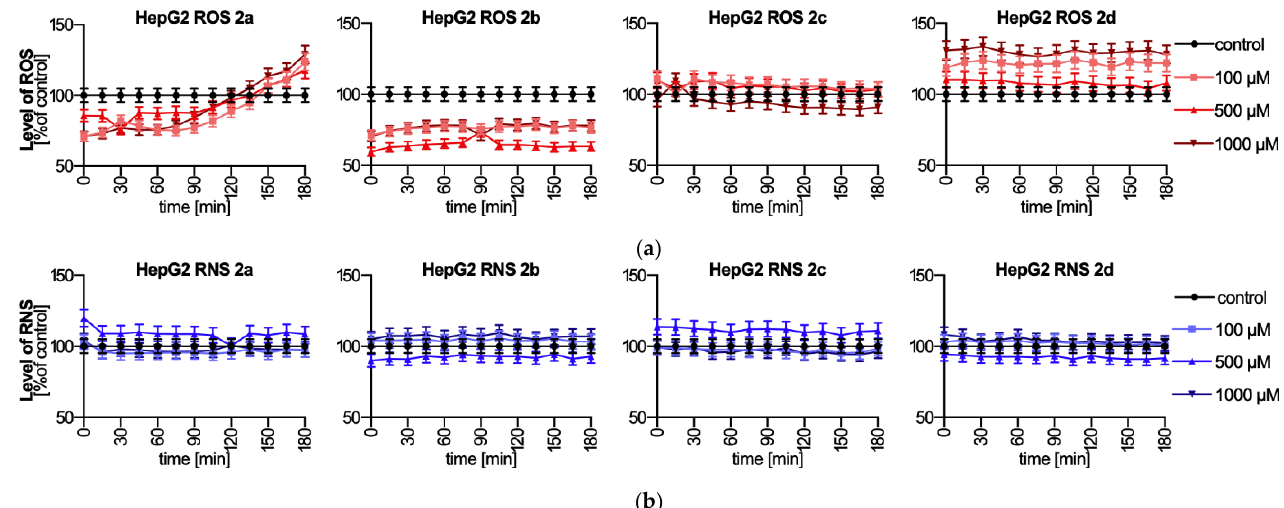
Figure 6. Comparison of changes in ( a ) ROS and ( b ) RNS levels in HepG2 cells treated with three different concentrations (100, 500 and 1000 μ M) of 2a – 2d for 0–180 min compared to ROS and RNS levels in a control sample (100%). ROS and RNS formation were tested overtime, in the range of 0–180 min after the adding of the tested compounds. Results are presented as mean ± SD from three independent experiments. The significance of differences was estimated based on multifactor ANOVA and post-hoc Tukey tests. Statistical analysis for ROS level: HepG2+2a: p < 0.01: control vs. 120 min (100, 500 and 1000 μ M); p < 0.001 control vs. 0–105 min and 165–180 min (100, 500 and 1000 μ M); HepG2+2b: p < 0.001: control vs. 0–180 min (100, 500 and 1000 μ M); HepG2+2d: p < 0.001: control vs. 0–180 min (100 and 1000 μ M). Statistical analysis for RNS level: HepG2+2a: p < 0.05: control vs. 0 min (500 μ M); HepG2+2c: p < 0.05: control vs. 0–180 min (500 μ M). For more experimental details please see “Materials and Methods”.